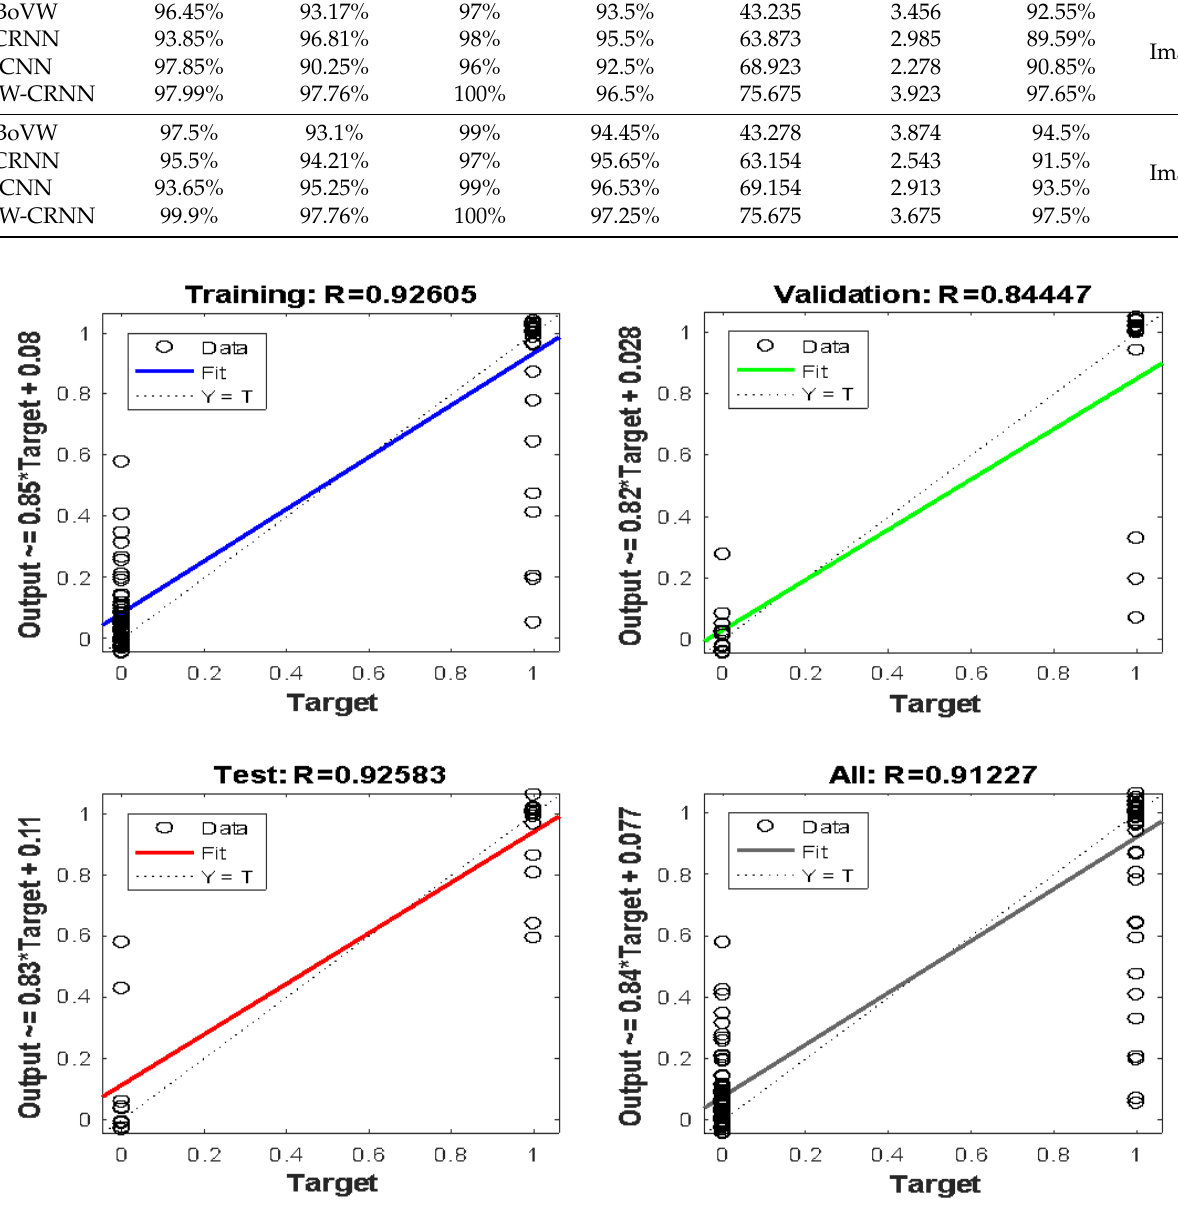
Figure 14. The performance of the given instructions, evaluation, and test sets. Table 7. Accuracy and Error Comparison of